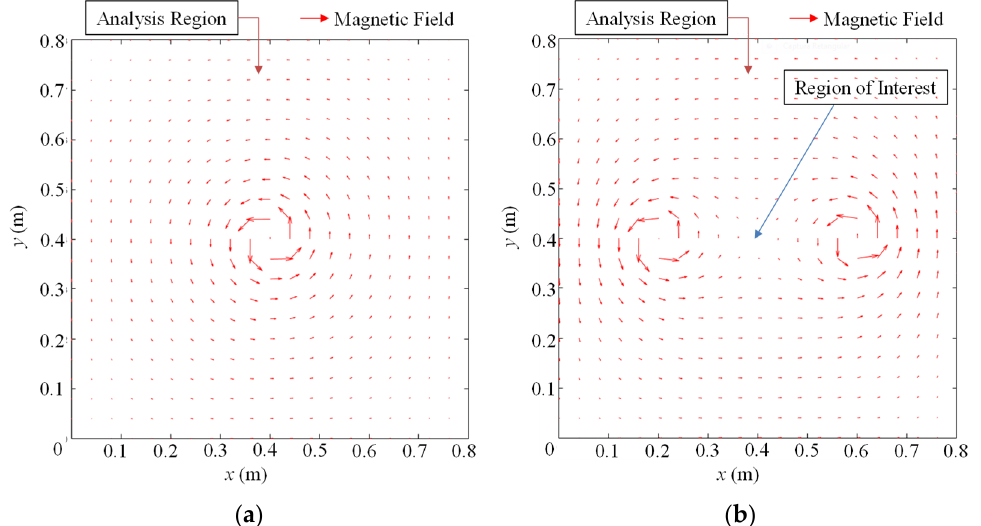
Figure 3. Total magnetostatic fields: ( a ) for a single conductor; ( b ) for two parallel